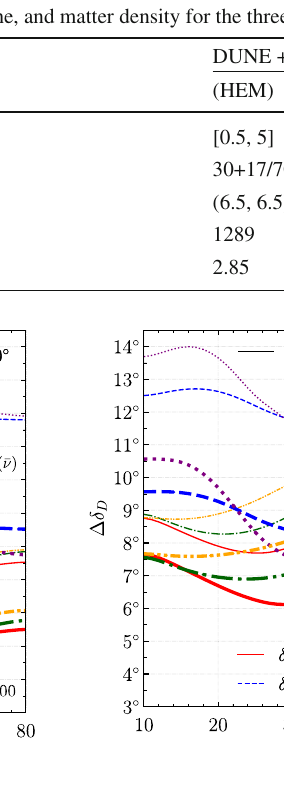
Fig. 12 TheCPphaseuncertainty, (cid:8)δ D ,forthecombinationofDUNE and THEIA as a function of the μ THEIA baseline L for true values δ true = 0 ◦ (red), 90 ◦ (blue), 180 ◦ (green), 270 ◦ (purple), and 150 ◦ D (orange). While the LBNF flux runs for 6.5 years each in the neutrino and anti-neutrino modes, μ DAR provides 10 years for the anti-neutrino